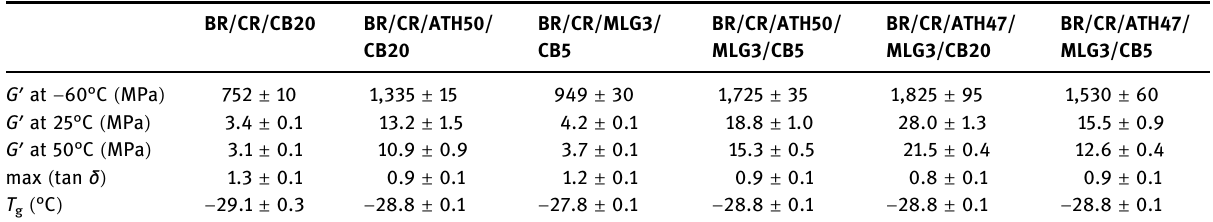
Table 4: Storage modulus ( G ′ ) values at − 60°C, 25°C, and 50°C, maximum damping factor peak ( tan δ ) , and the glass transition temperature ( T ) of BR/CR g